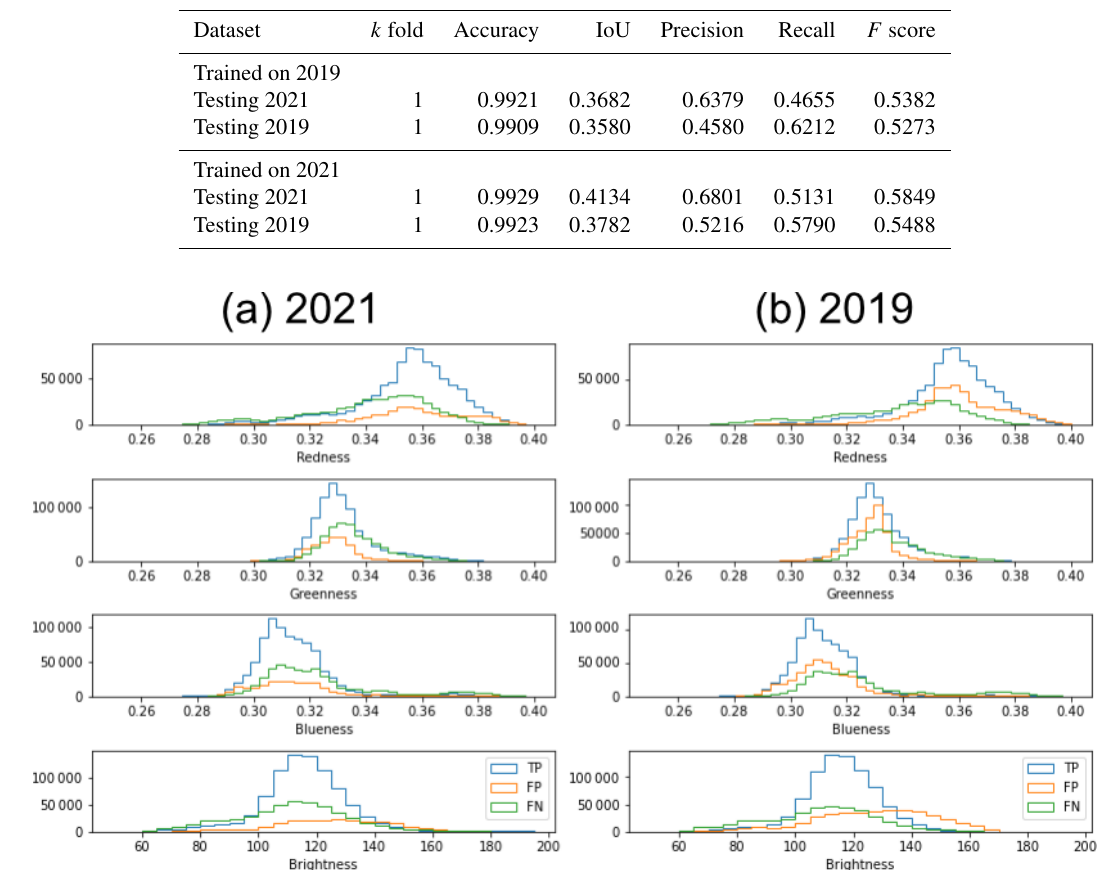
Table 6. Comparison of test dataset performance model trained on 2019 imagery and labels with the model trained on 2021 imagery and labels.